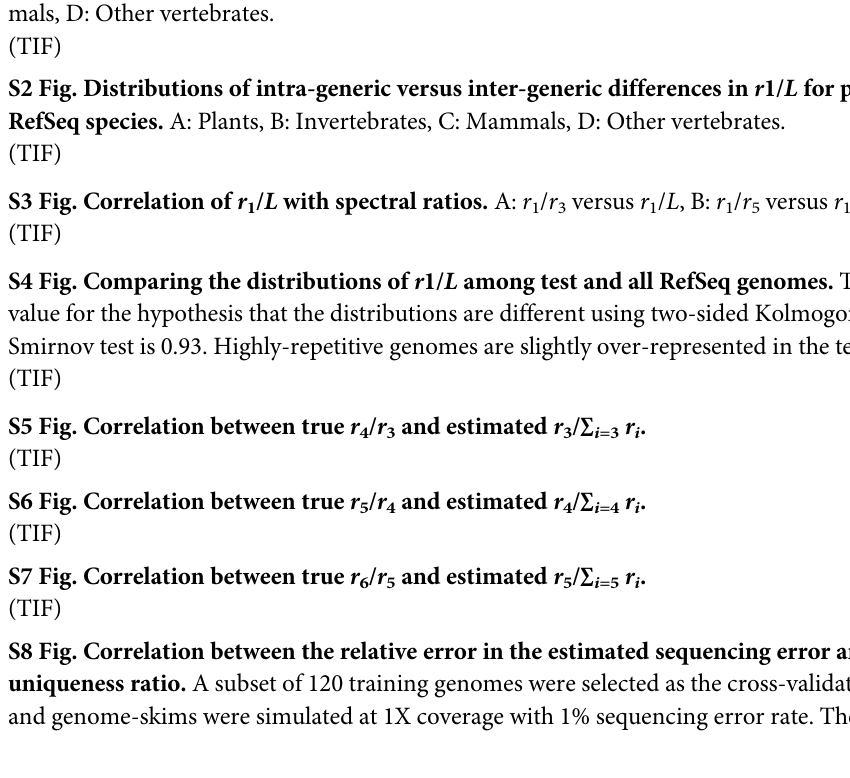
/ L annotation. A: Plants, B: Invertebrates, C: Mam- 1 / L with spectral ratios. A: r / r versus r / L , B: r / r versus r / L . 1 1 3 1 1 5 1 / r and estimated r / ∑ . r 4 3 3 i =3 i / r and estimated r / ∑ . r 5 4 4 i =4 i / r and estimated r / ∑ . r 6 5 5 i =5 i